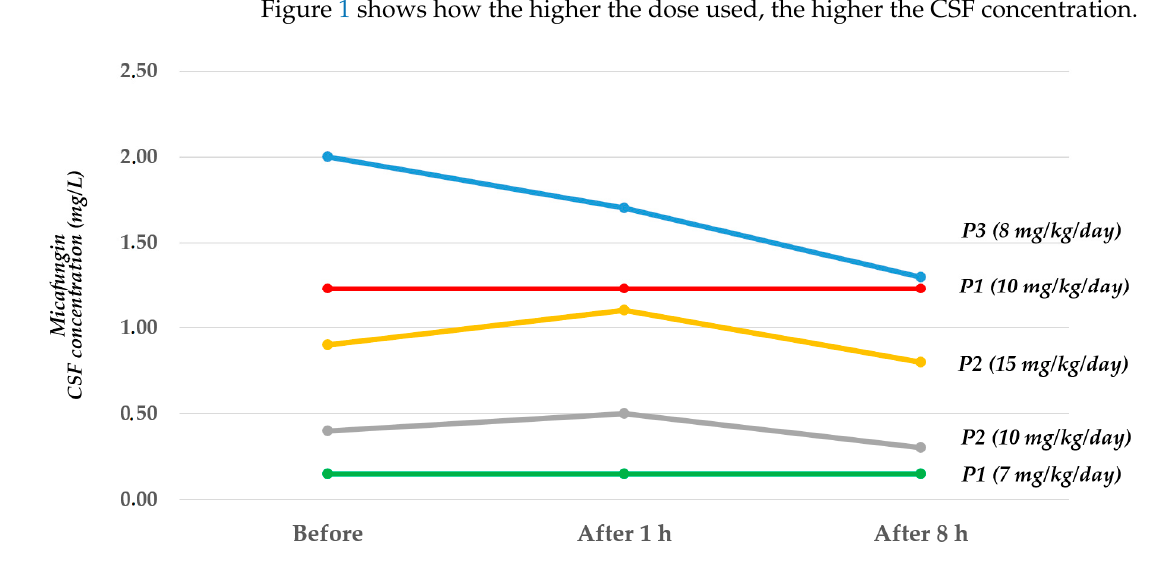
Figure 1. Micafungin concentrations in cerebrospinal fluid before and after different dose infusions in three infants with Candida meningitis.